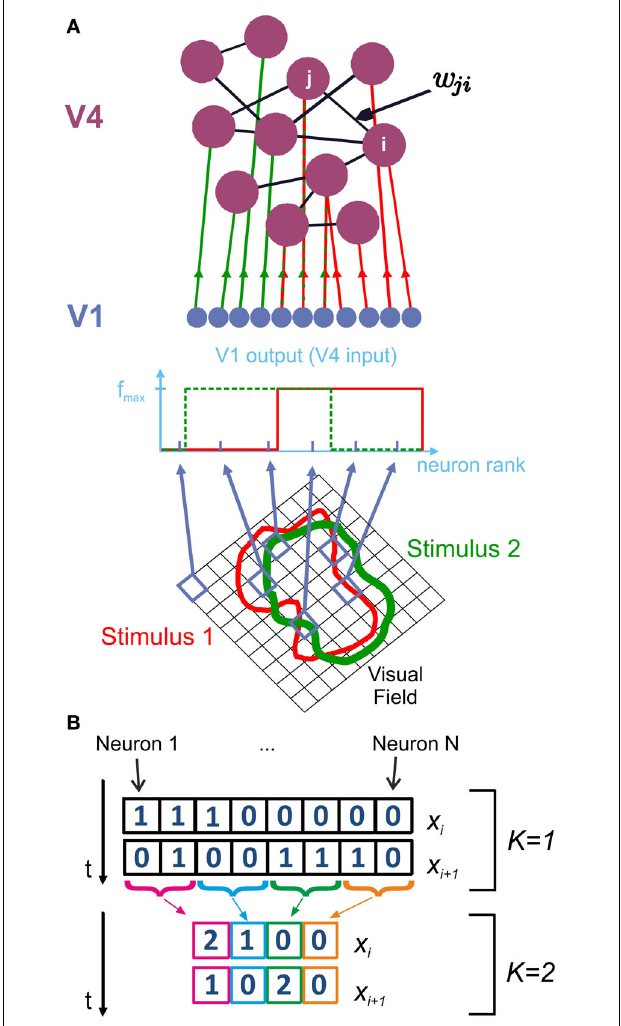
FIGURE 1 | Network structure and analysis of spike patterns. We model V4 populations using a randomly coupled recurrent network of mixed excitatory (80%) and inhibitory (20%) integrate-and-fire neurons. (A) Depending on their receptive field properties, a different set of V1 neurons are activated by different stimuli. Activated V1 neurons provide feedforward input to V4 neurons j in the form of Poisson spike trains with rate f max . Consequently, a different, random subset of V4 neurons are driven by external input for each stimulus. Recurrent connections within V4 are represented by the random, non-symmetric coupling matrix w ji . (B) Information entropy of the spike patterns generated by area V4 is calculated using state variables x i . At the finest observation scale ( K = 1), x i consist of N -dimensional binary vectors, which represent whether each neuron j fired a spike (1) or not (0) at a given point in time. For larger K , the activity of K adjacent cells is summed to construct x i